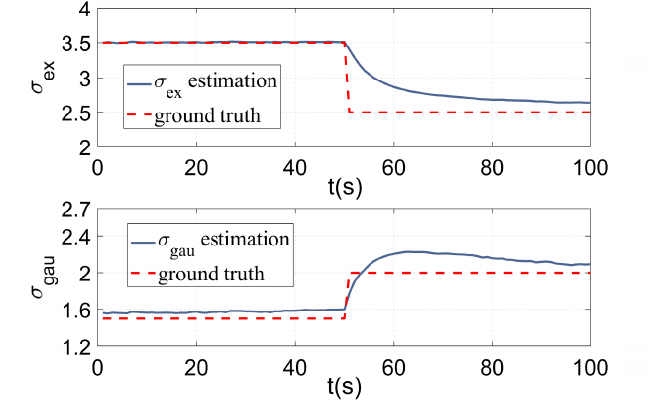
Figure 6. Estimation of σ ex and σ gau vs. ground truth for a shape deformation